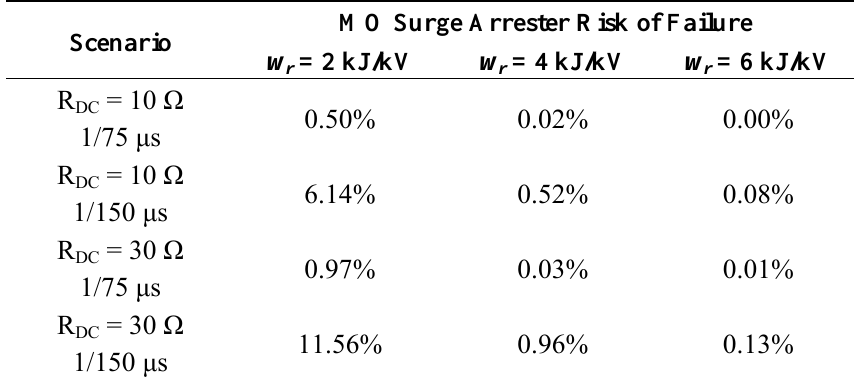
Table 2. Risk of failure obtained for the MO surge arresters installed at the wind turbine stricken by